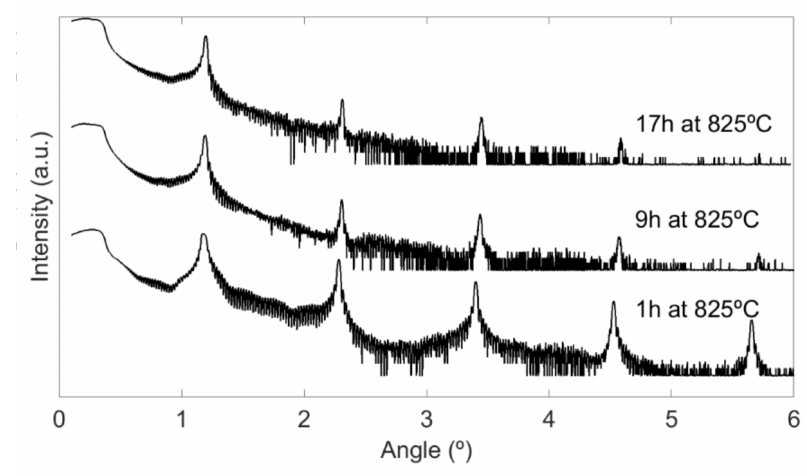
Figure 5. SAXRD spectra of a short (~3.8 nm) period WC/SiC after being annealed at 825 ◦ C for 1 h, 9 h and 17 h. This multilayer consists of 50